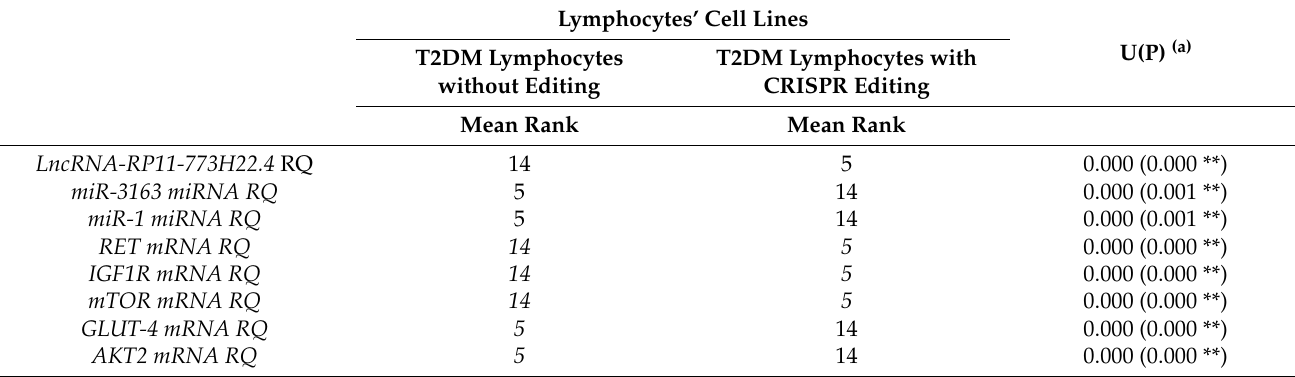
Table 4. Differential expression of LncRNA - RP11-773H22.4, miR-3163 and miR-1 miRNAs RET, IGF1R, m-TOR, GLUT4 and AKT2 mRNAs between lymphocyte cell lines before and after CRISPR/Cas9